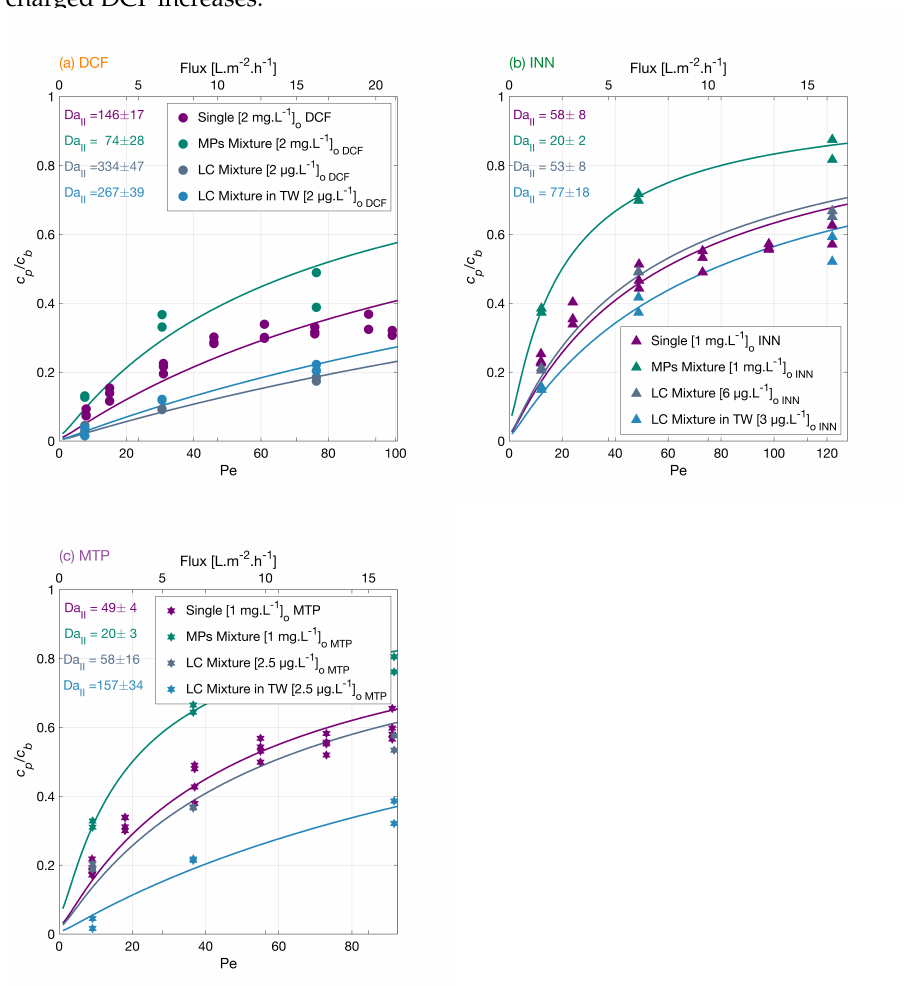
Figure 6. Degradation of ( a ) DCF, ( b ) INN, and ( c ) MTP independently, in a mixture, in a mixture with low concentrations and in tap water. Symbols depict experimental results, and lines correspond to the mass transport and surface reaction model. Conditions: the legend shows the feed concen- trations [ c b ] o , 366 nm radiation, 210 W · m − 2 and 142 mg · L − 1 Na 2 SO 4 for the experiments with the MPs independently and in a mixture, 23.4 mg · L − 1 NaHCO 3 for the experiments in a mixture in low